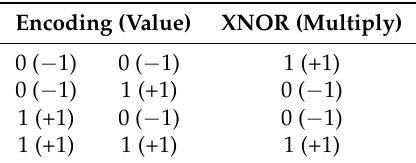
Table 1. This table shows how the XNOR operation of the endorsing can be equivalent to multiplications of the binary values, in